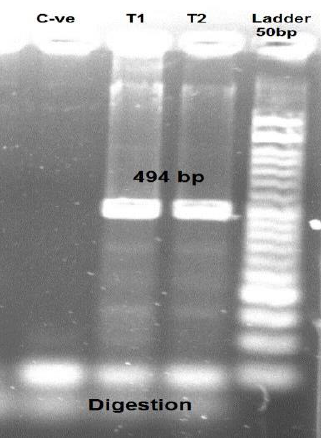
Fig. 3. TPMT *3C before adding restriction enzyme (digestion) Fig. 4. TPMT*C products after adding digestion